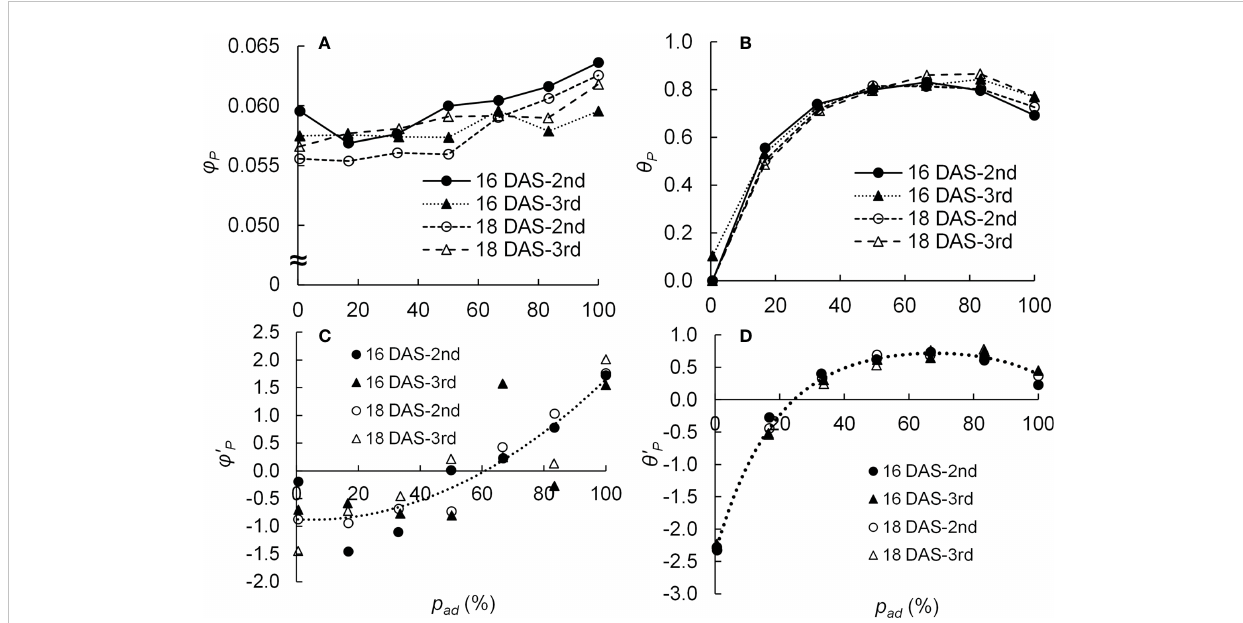
FIGURE 2 Relationship between the proportion ( p ad ) of photosynthetic photon fl ux density (PPFD) on the adaxial surface of a leaf to the total PPFD on both surfaces of a leaf and the initial slope ( j P ) (A) as well as the convexity ( q P ) (B) of the light response curve of photosynthesis of the 2nd and 3rd leaves of komatsuna sixteen and eighteen days after sowing (16 DAS and 18 DAS, respectively) ( n = 21 – 26). The relationship between p ad and the z-score of the initial slope ( j ’ P ) (C) as well as the z-score of the convexity ( q ’ P ) (D) of the light response curve of photosynthesis of 2nd and 3rd leaves of komatsuna 16 DAS and 18 DAS ( n = 21 – 26). j ’ P and q ’ P were calculated from j P and q P values at each DAS and leaf position (2nd or 3rd). The dotted lines in (C, D) were calculated using Eq. (4) and Eq. (5),